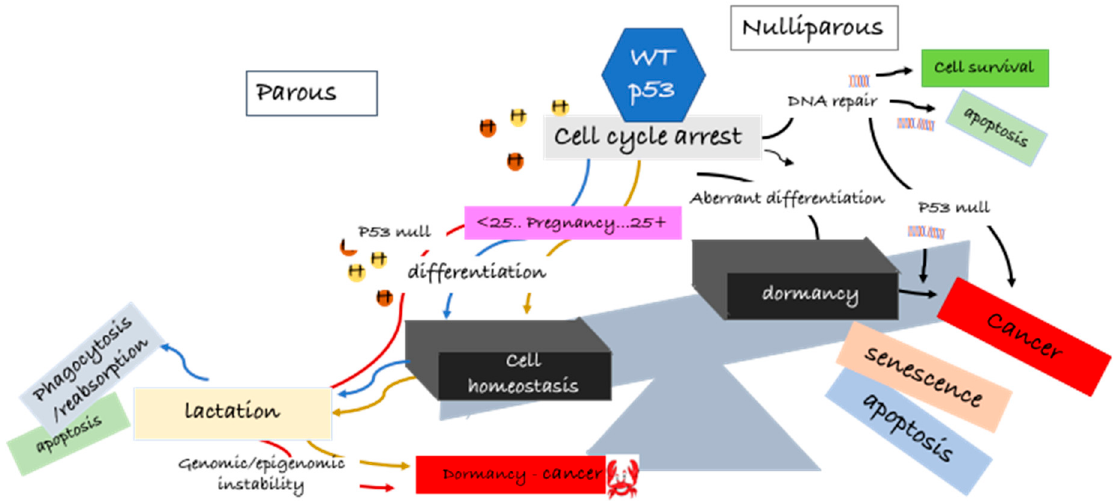
Figure 1. A role for p53wt in breast cancer origin and latency—p53wt “good guy–bad guy” hypothesis. During pregnancy (before 25 years of age), under the influence of the female hormones (estrogen and progesterone), p53 participates in stepwise chromatin remodeling and epigenetic reprogramming. These reprogramming events imprint a lasting protective signature on mammary cells, maintaining homeostasis (blue line). After lactation, wasted cells are phagocytosed and reabsorbed or undergo apoptosis. Mammary glands in females over the age of 25 years undergo the same process; however, because of the potential genomic and epigenetic instability, resulting from the continuous pre-pregnancy hormonal flux over the years, the mammary cells are not protected against latent breast cancer. The mammary cells may remain in a pre-cancerous dormant state for decades until stimulated by mitogens to proliferate (gold line). In nulliparous females, p53null mammary cells also produce active lactating cells but are highly vulnerable to spontaneous cancer (red line). p53 tries to repair the damaged cells for survival (black line). If DNA damage cannot be repaired, cells undergo apoptosis, senescence, or remain in a pre-cancerous dormant state (black line). In aberrant differentiation, 53wt tries to repair the DNA mismatches. If unable to complete the repair, the cells undergo apoptosis or become precancerous cells (black lines). Aberrant differentiation can also lead to dormancy and, thereafter, apoptosis, senescence, or emerging of latent breast cancer cells (black line). Hypothetically, recurrence of breast cancer may follow the process of dormancy, i.e., cells do not die but remain in a vulnerable pre-cancerous state.